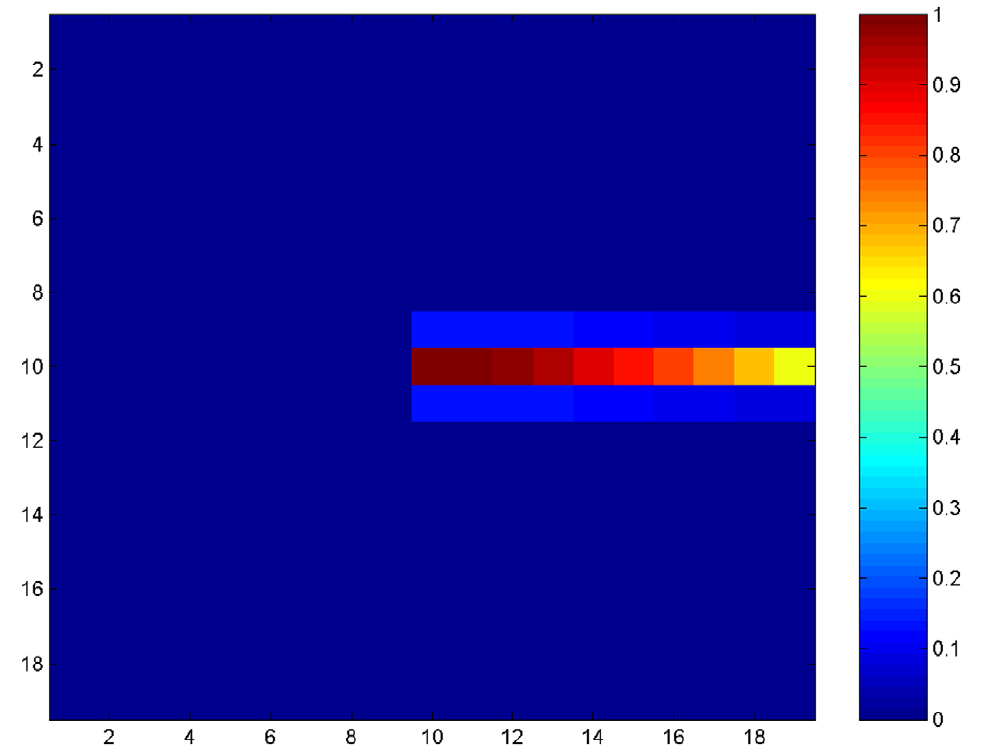
Figure 2. Kernel used to represent lateral connectivity in the extrastriate module. This kernel is convolved with the outputs of cells in the extrastriate cortex to give lateral inputs to horizontally selective cells. Hence, this kernel gives the weights of lateral inputs from neighbouring cells. The plot shows that inputs are strongest locally and horizontally towards the right, which is toward the intact hemifield in our simulations.